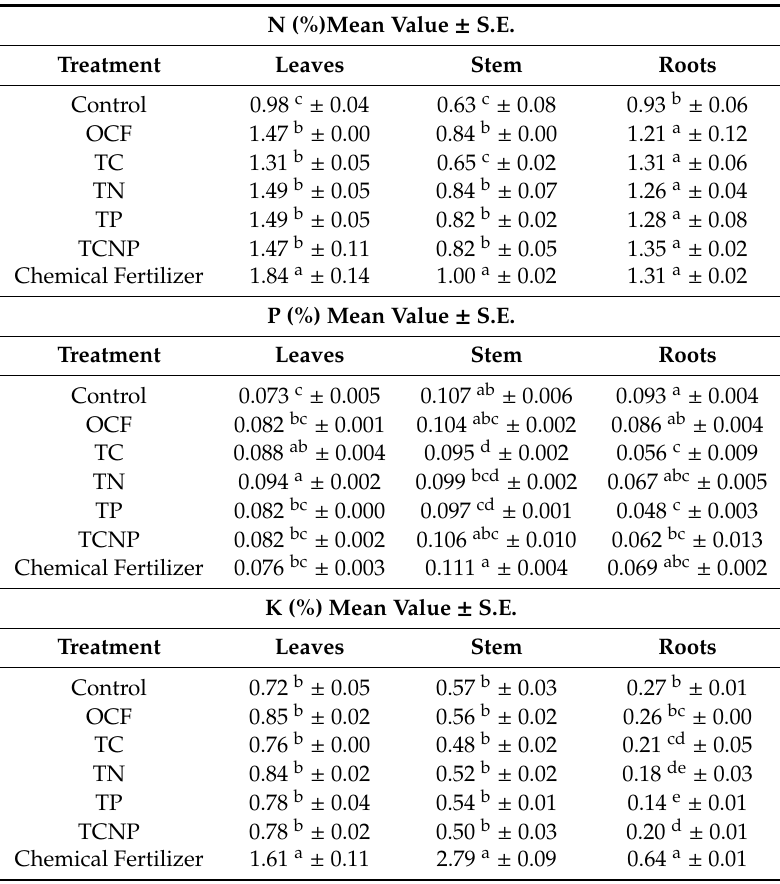
Table 4. E ff ect of treatments on the concentrations of nitrogen, phosphorus and potassium in leaves, stem and roots of maize plant at fifty-six days after